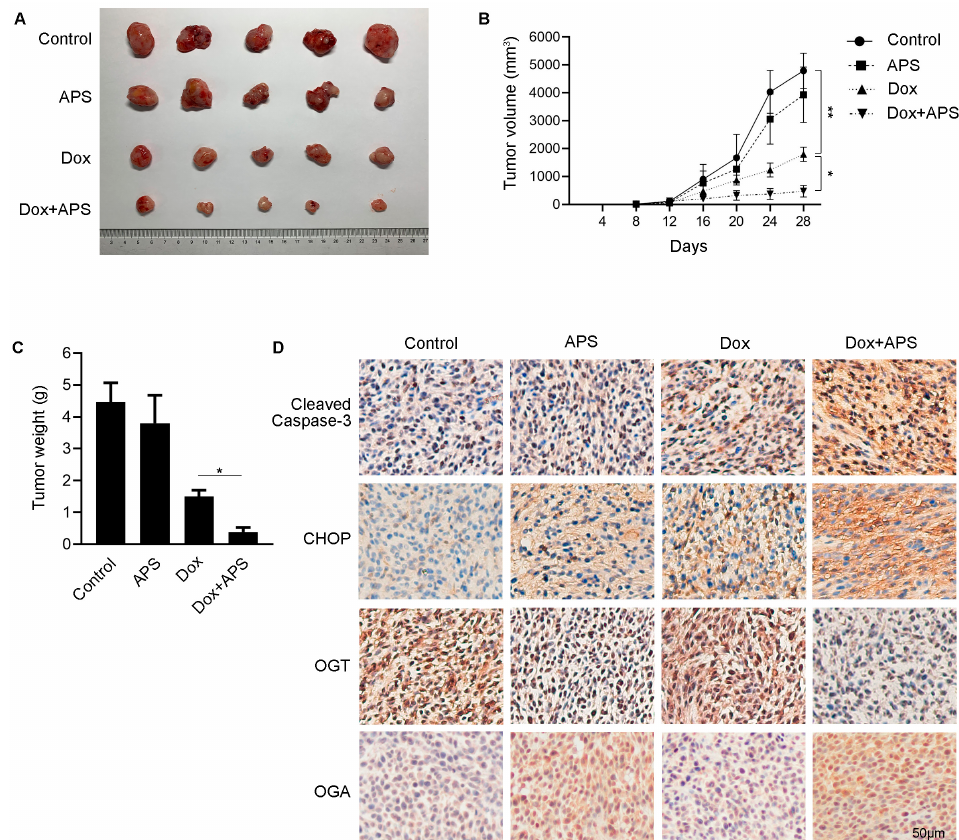
Figure 6. APS strengthens the tumor growth inhibitory effect of Dox in Hep3B xenograft tumor. BALB/c nude mice were inoculated with Hep3B cells subcutaneously at day 0. Mice were intraperitoneally injected at day 7; the treatment was performed every 3 days and lasted to day 28. Treatment was as follows: 1. Control (saline), 2. APS (50 mg/kg), 3. Dox (2 mg/kg), 4. Dox (2 mg/kg) + APS (50 mg/kg). ( A ) Subcutaneous tumors in BALB/c nude mice were harvested at day 28 (n = 5). ( B ) Tumor volumes (mm 3 ) were monitored for 28 days by measuring with vernier caliper. ( C ) Tumor weights (g) were measured when the mice were sacrificed at day 28. ( D ) Sections of the excised tumors of each group were processed for immunohistochemistry. Scale bar, 50 µ m. Data are expressed as mean ± SEM, n = 5, *, p < 0.05, **, p <